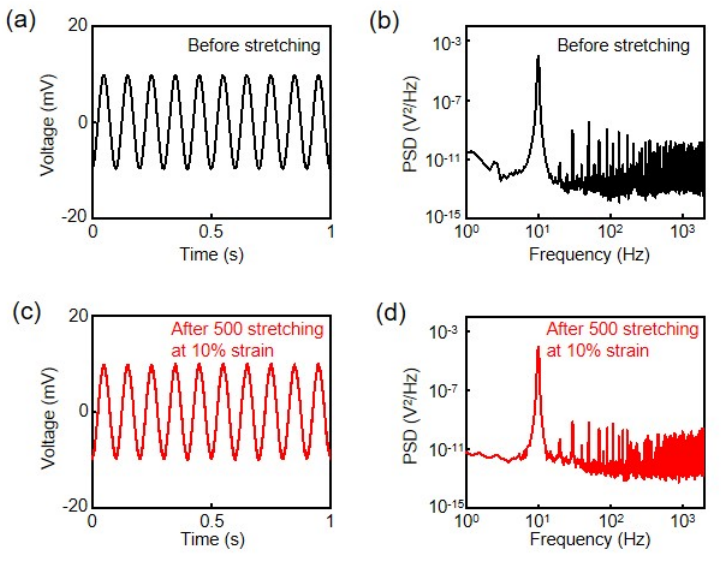
Figure 4. ( a ) Benchtop recording results from the pristine Ag NW microelectrodes, with a 20 mV peak-to-peak amplitude, 10 Hz sine wave input. ( b ) PSD of the electrical signals recorded by the Ag NW microelectrodes in ( a ). ( c ) Benchtop recording results from the stretched Ag NW microelectrodes, with the same 20 mV peak-to-peak amplitude, 10 Hz sine wave input. ( d ) PSD of the electrical signals recorded by the stretched Ag NW microelectrodes in ( c ).